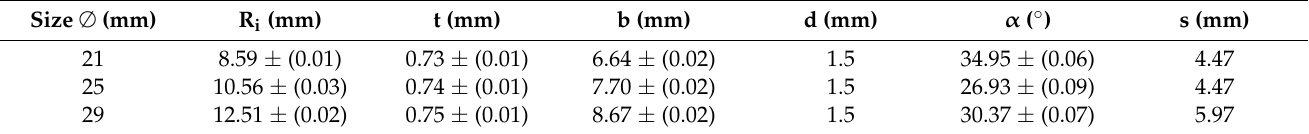
Table A1. Settings values of the experimental set-up and characteristic dimensions of samples produced through the historical deposition process that underwent the three-point bending test. R i , t, b, d; α and s indicate, respectively: the internal radius, the thickness, the width, the roller diameter, the support angle, and the half distance between the supporting rollers.